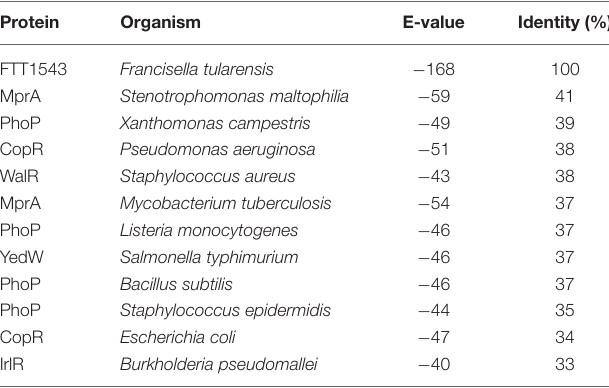
TABLE 1 | Sequence comparison of BfpR with other well-known response